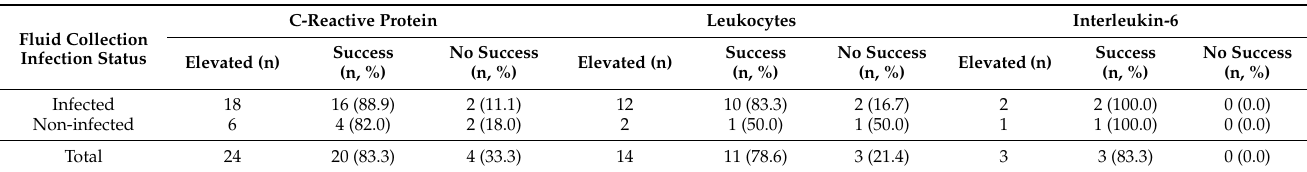
Table 3. Distribution of the success rate in terms of decreasing laboratory parameters between infected and non-infected fluid